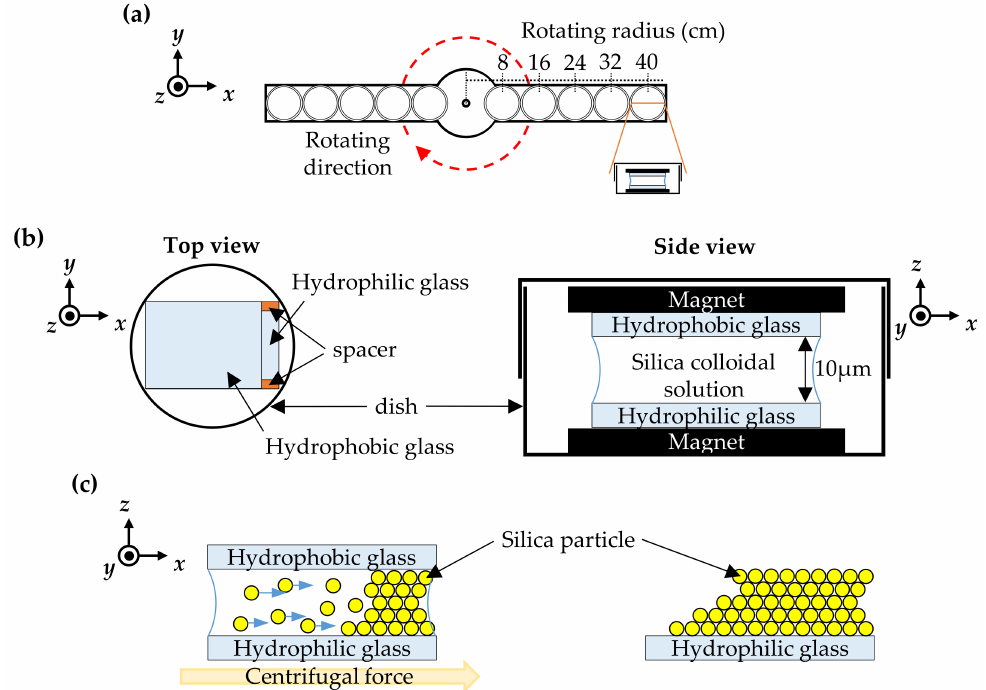
Figure 1. Schematics of the experimental setup for depositing and stacking silica particles with different radii of rotation and rotational speeds. ( a ) The rotation arms; ( b ) composition of the cell; and (c) schematic diagram of silica particles during the